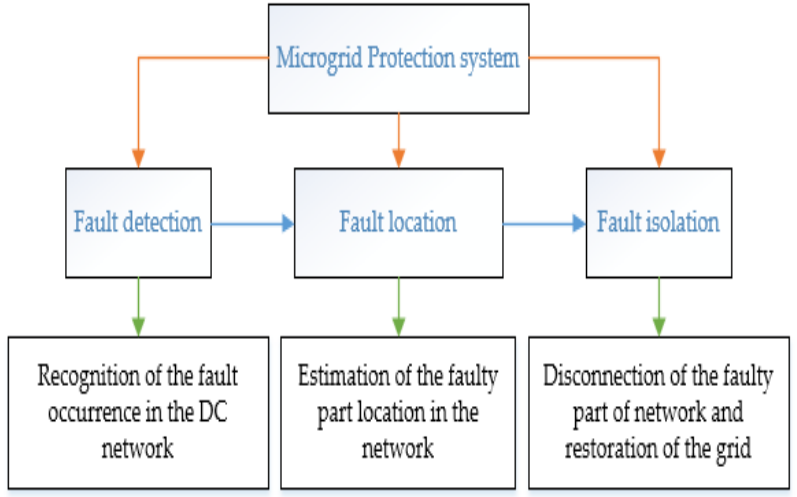
Figure 3. Proposed flowchart for protection schemes for a DCMG system .